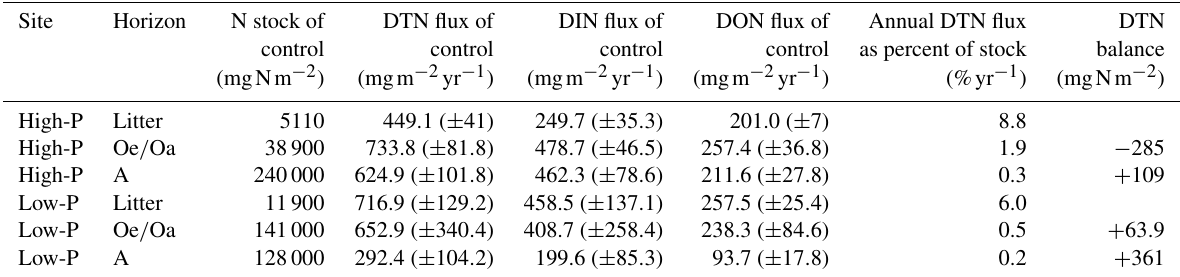
Table 4. Comparison of dissolved organic, inorganic, and total nitrogen fluxes (DON, DIN, DTN) from litter, Oe / Oa, and A horizons with respective stocks (average of three field replicates taken in July 2019) of each horizon at the high-P site and the low-P site. Balances: the difference between the fluxes into and out of a given horizon; positive values reflect net accumulations and negative values net losses. Data from unfertilized plots ( n = 3). Means ± standard error (SE). Data for dissolved organic carbon can be found in Sect.